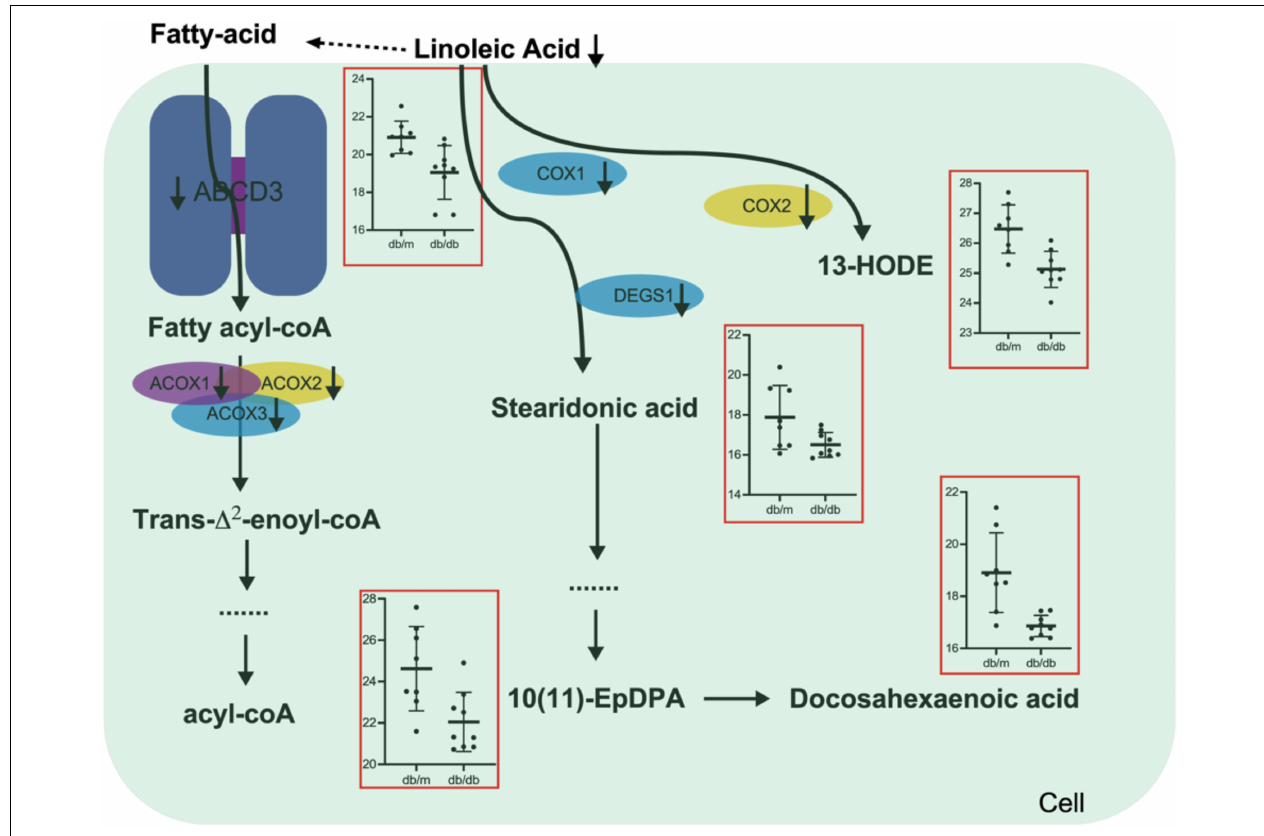
FIGURE 6 | Schematic diagram of the linoleic acid metabolism and fatty-acids β -oxidation alterations during DN pathogenesis and progression.